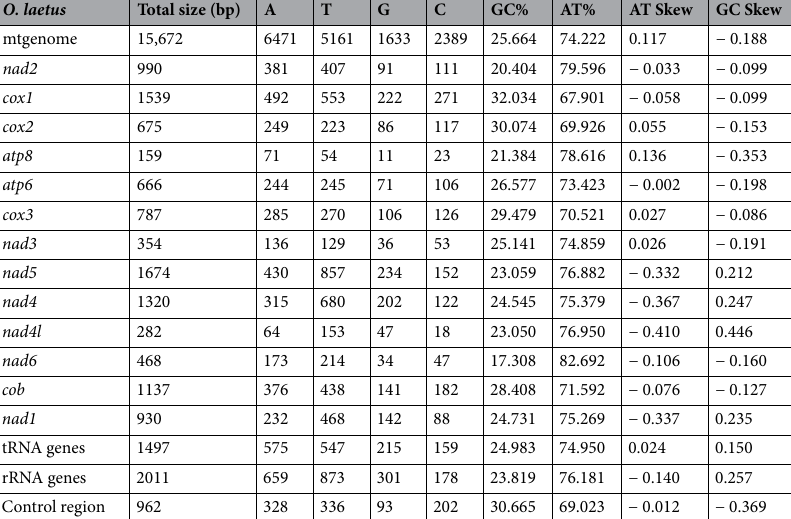
Table 5. Nucleotide composition and skewness of the mitogenome of O. laetus.